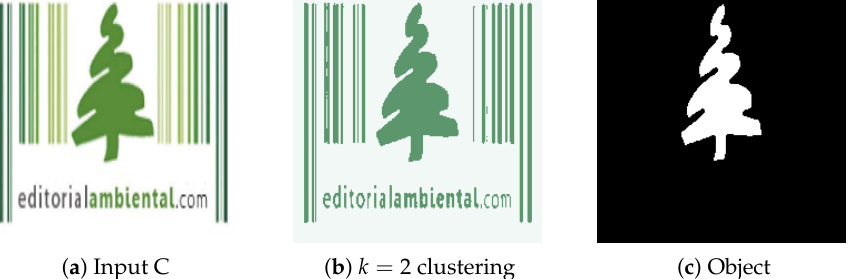
Figure 12. ( a ) Experiment C input; ( b ) Experiment C K-Means clustering ( k = 2); ( c ) Experiment C extracted region.